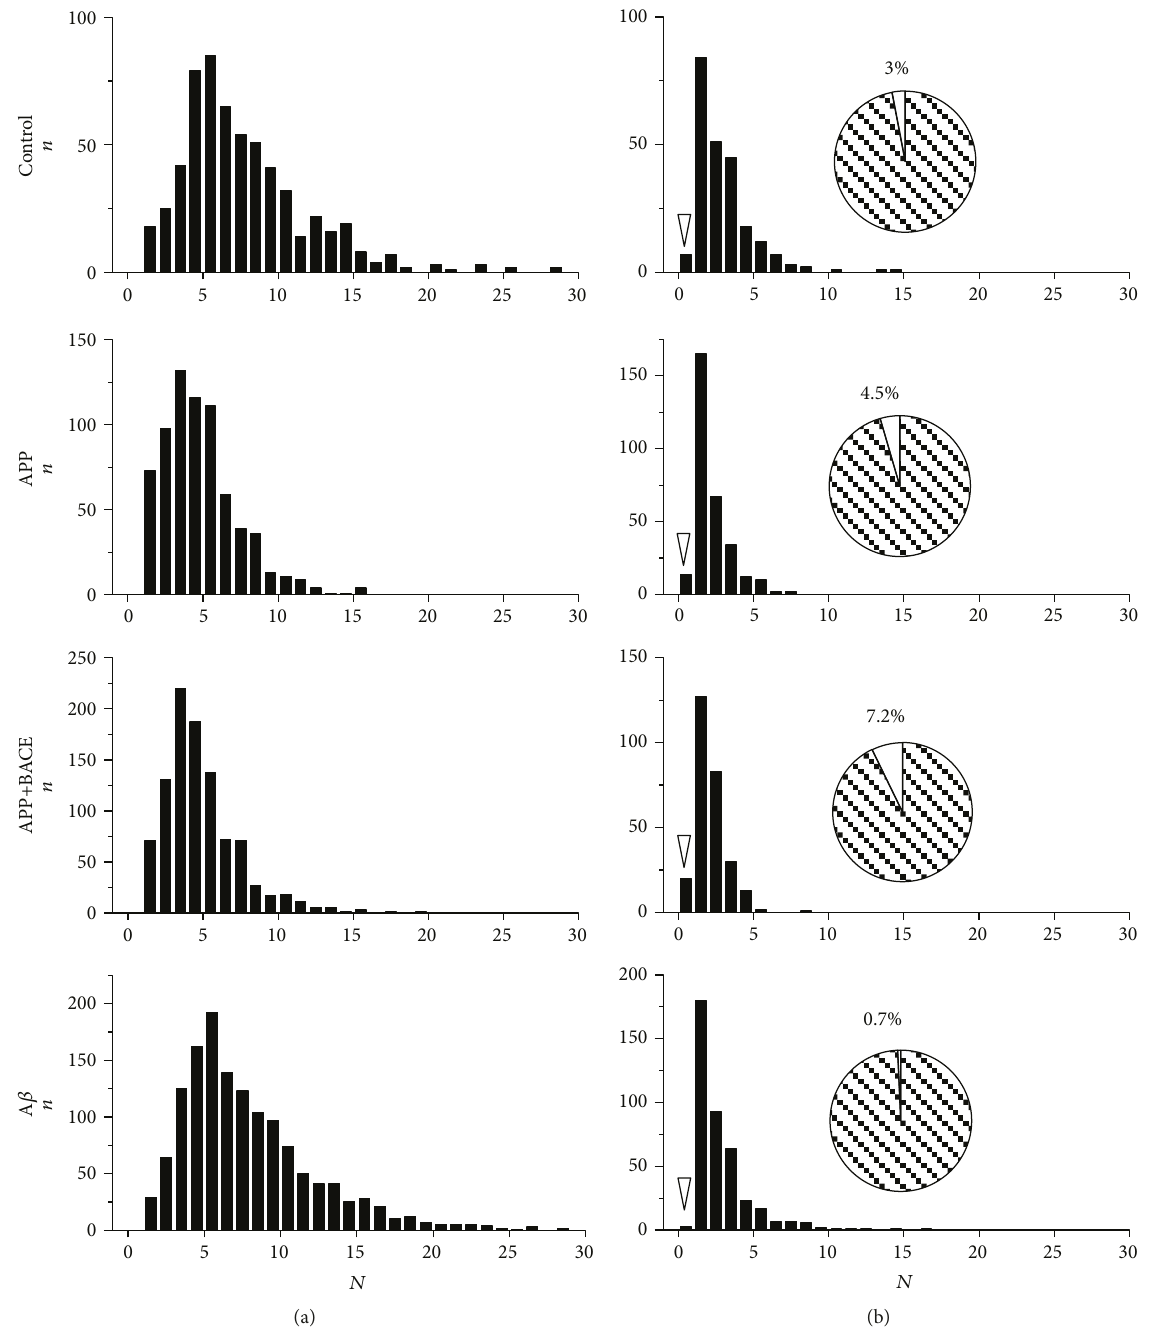
Figure 2: Muscle 4 neuromuscular junction. Bruchpilot cluster (active zone) distribution in individual synaptic boutons from transgenic Drosophila melanogaster larvae. Distributions for the control, APP, APP+BACE, and А β lines are shown. (a) 1b boutons. (b) Satellite boutons; arrowheads identify the boutons containing no AZs. Insets — circle charts showing percentage of satellite boutons containing no AZs. N — active zone number per single